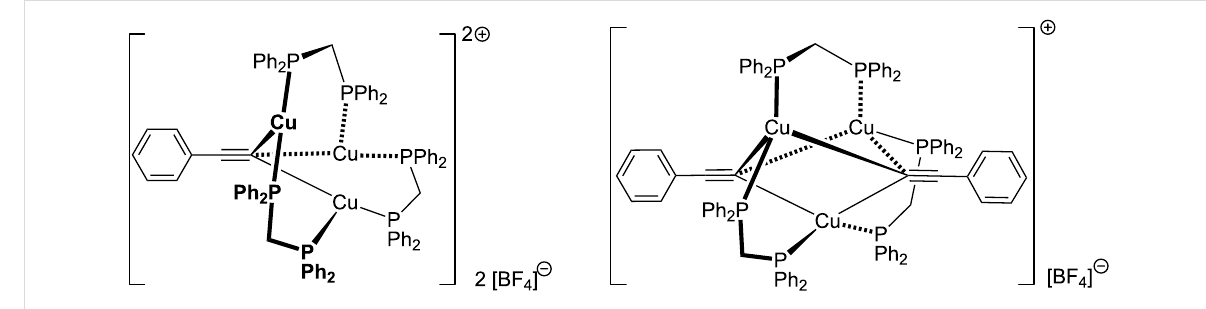
Figure 4: Schematic representation of the single crystal X-ray structures of copper(I) acetylide complexes [Cu 3 ( μ 3 -C ≡ CPh)( μ -dppm) 3 ][BF 4 ] 2 and [Cu 3 ( μ 3 -C ≡ CPh) 2 ( μ -dppm) 3 ][BF 4 ]